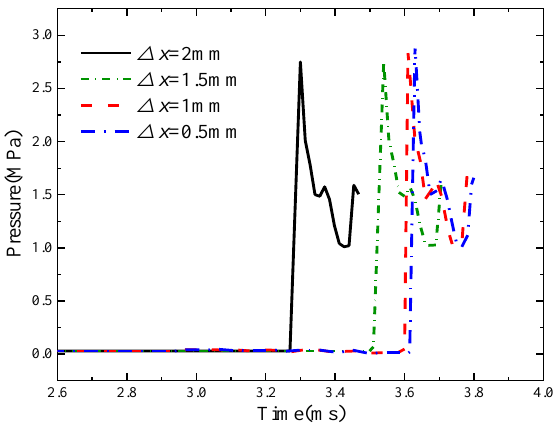
Figure 2. Mesh size independence analysis.